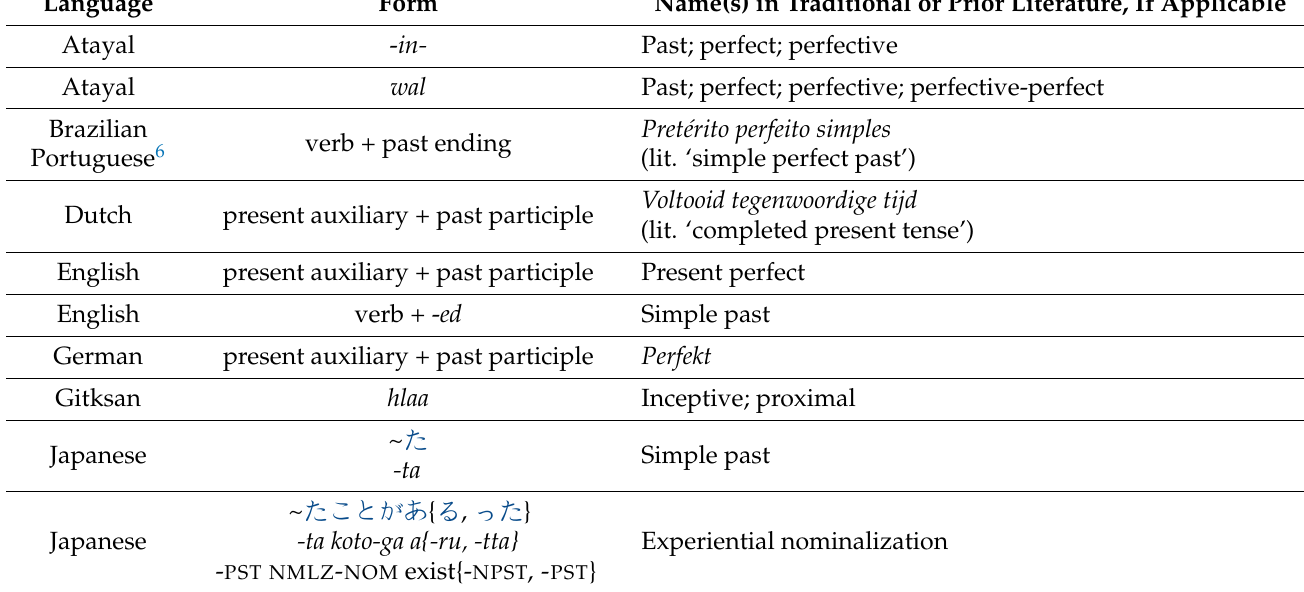
Table 1. Target forms